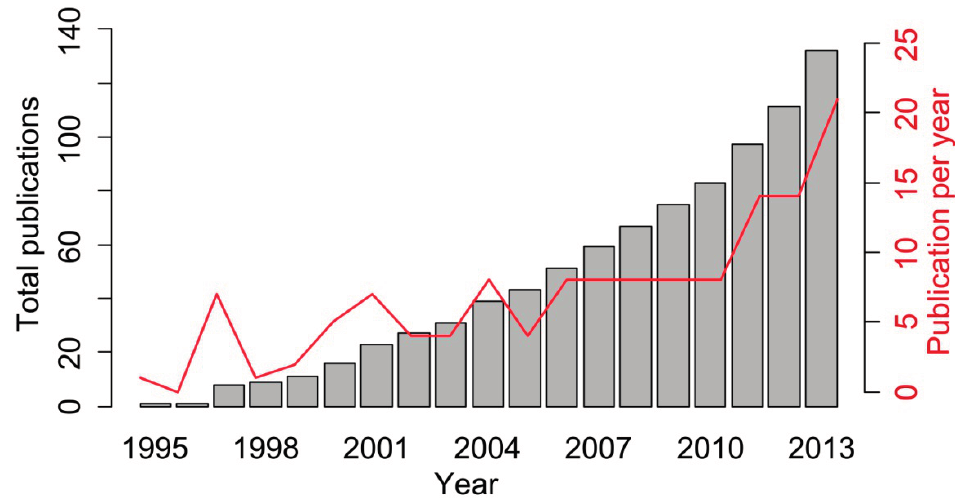
Figure 1. The number of publications from 1995 to